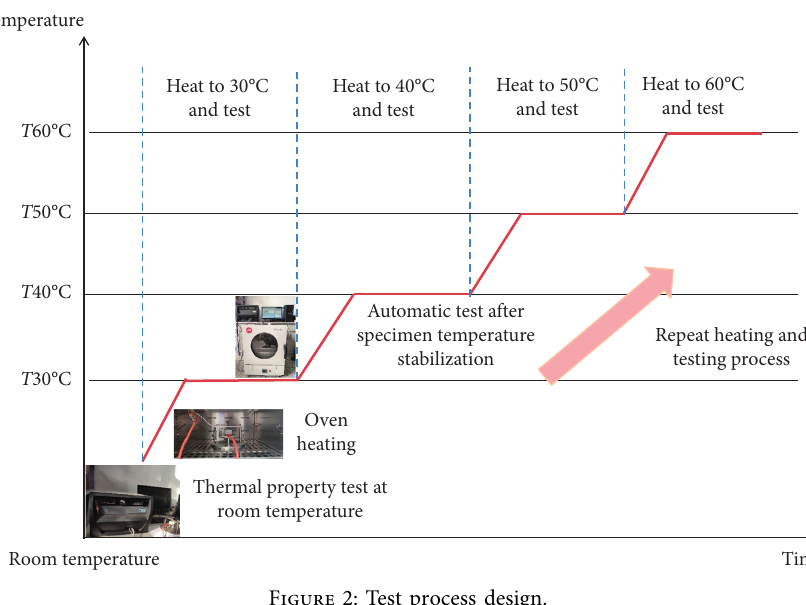
Figure 2: Test process design. Table 1: Thermophysical parameters of rock samples from 1,500–2,000m in the Xiling well construction area of Sanshandao gold mine. Depth m 1500 1600 1700 1800 1900 2000 Thermal conductivity W/(m .